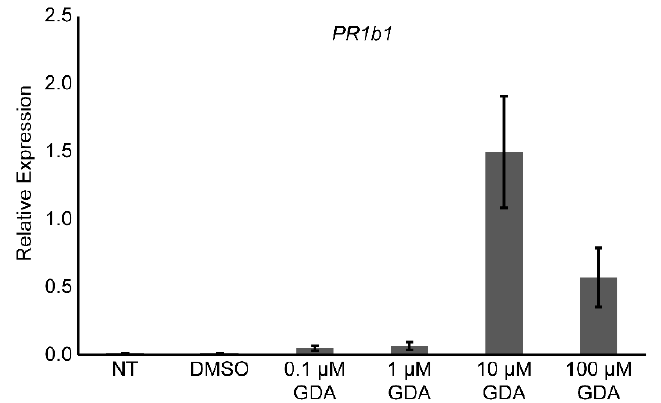
Figure 7. The relative expression level of PR1b1 in the leaves of the tomato cultivar Natsunokoma at 24 h after geldanamycin (GDA) treatment. Different GDA concentrations (0.1, 1, 10, and 100 µM) and 0.1% ( v / v ) dimethyl sulfoxide (DMSO) were applied by foliar spray. Gene expression levels were quantified by qPCR and normalized to GAPDH expression. Vertical bars indicate the standard error of the mean ( n = 4).